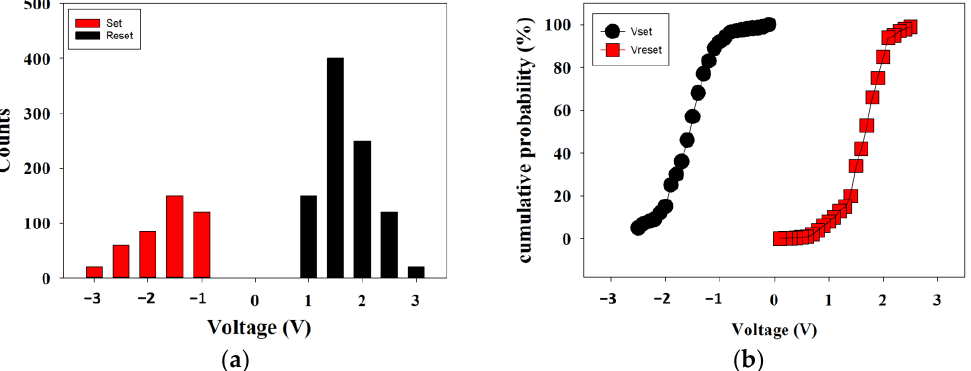
Figure 9. ( a ) The counts distribution results, and ( b ) the statistical results of cumulative probability for the resistive switching properties of the RRAM devices in set and reset (400 times).